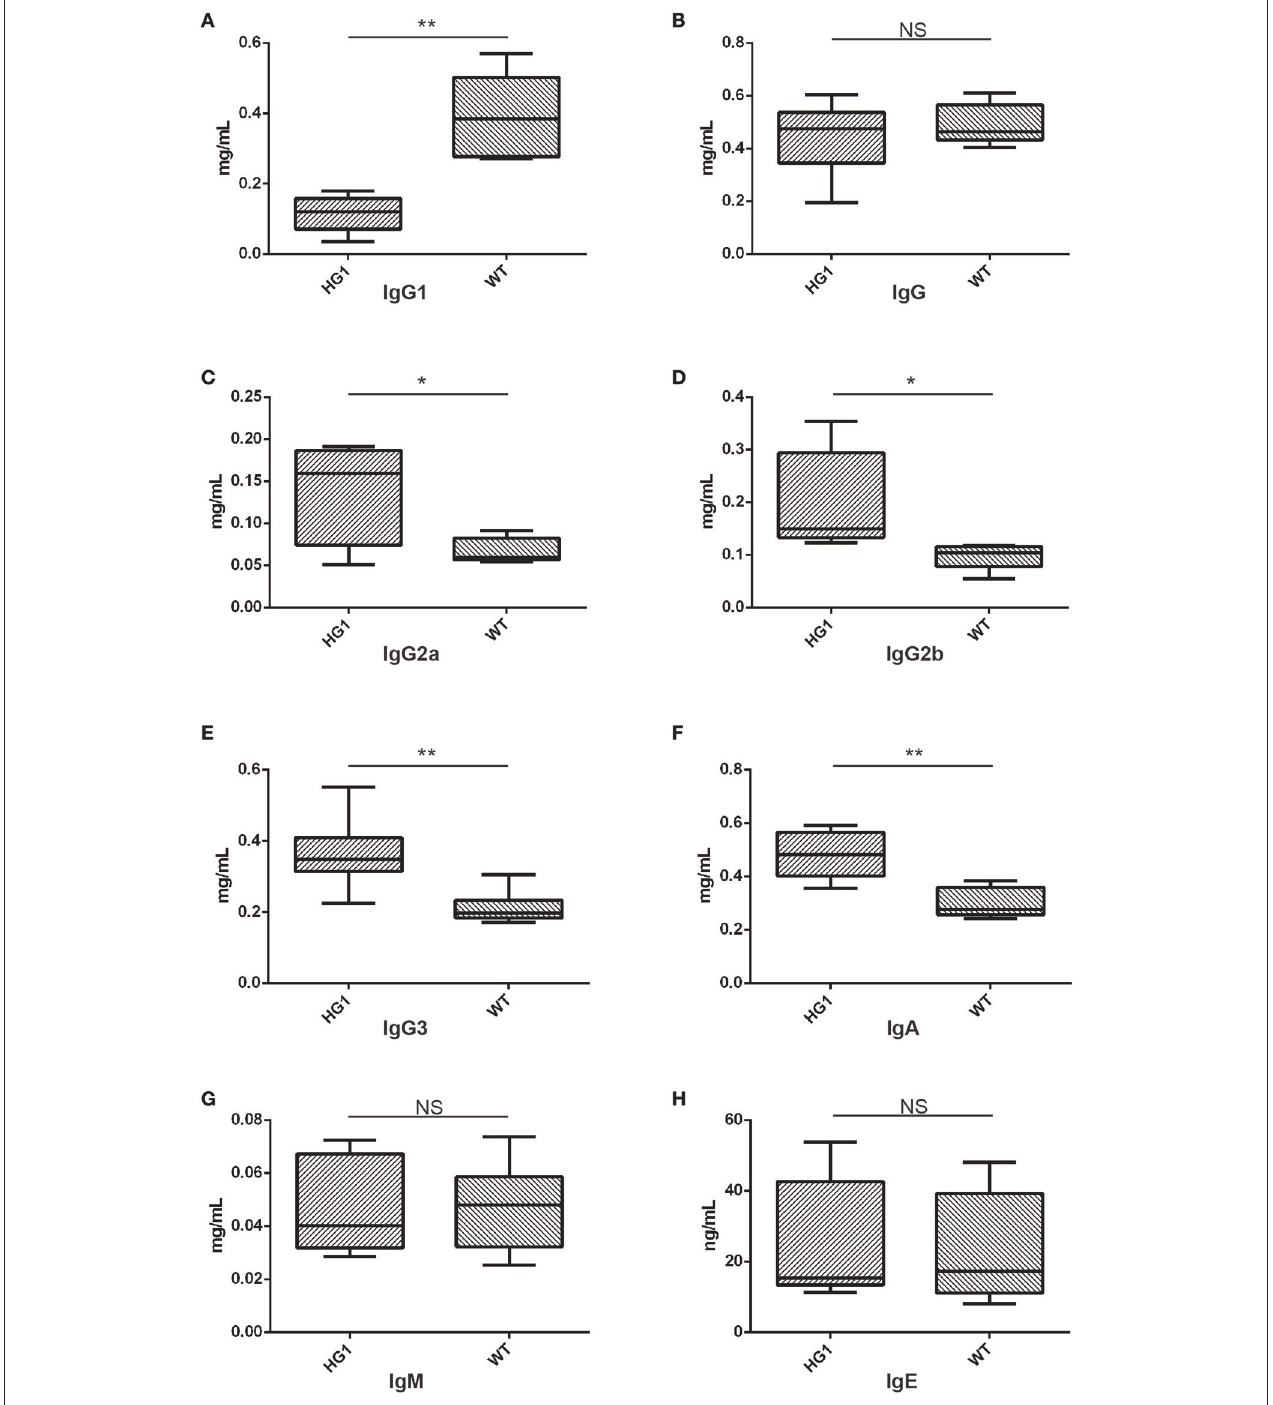
FIGURE 5 | ELISA detection of Ig concentrations in the sera of HG1 and WT mice. ( A–H ) Concentrations of IgG1, IgG, IgG2a, IgG2b, IgG3, IgA, IgM, and IgE, respectively. The asterisk rating system is used to indicate the P value: * P < 0.05, ** P < 0.01, *** P < 0.001 and NS stands for Not Statistically Significant.